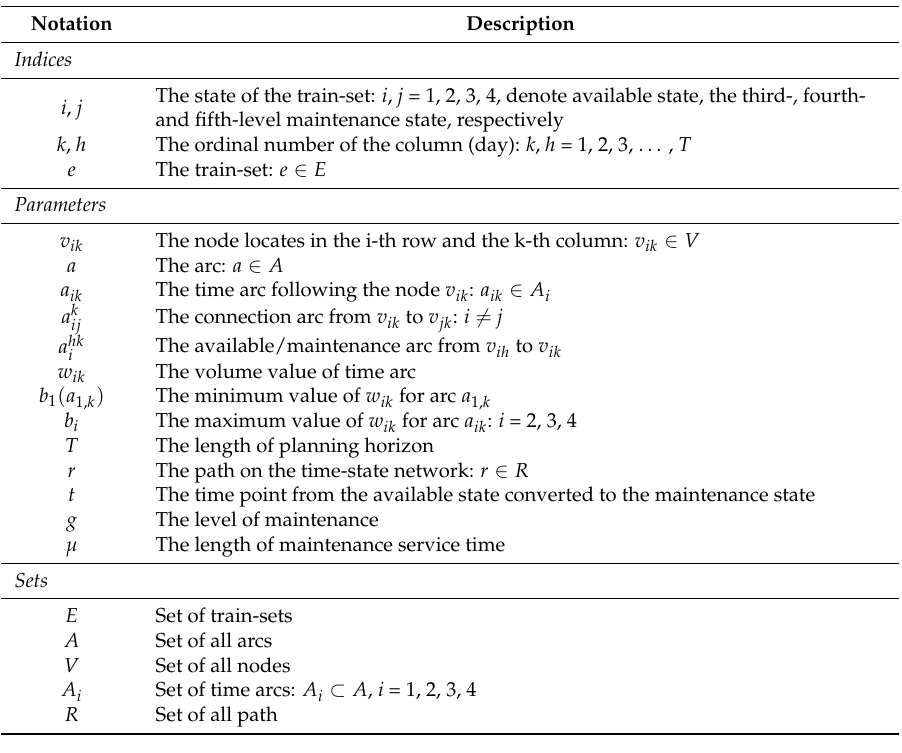
Figure 3. Schematic diagram of connection relationship between available and HM states for EMU. Table 2. Notation of indices, sets, and parameters.